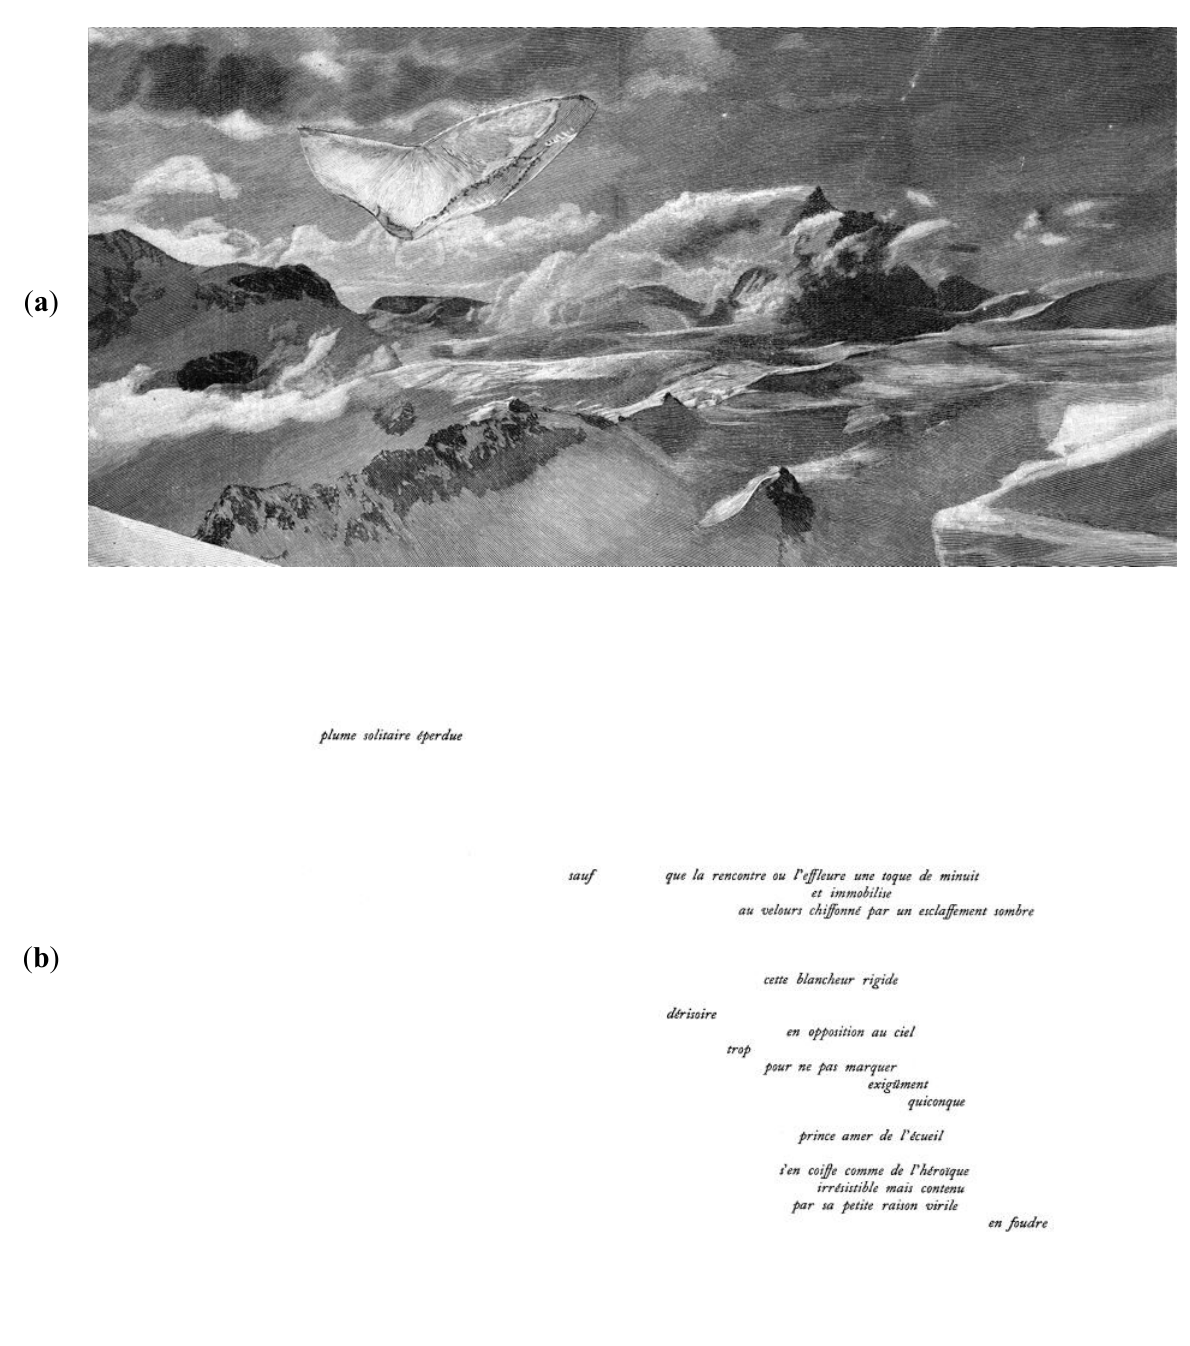
Figure 6. (a) Paper Collage comprised of original engravings from La Grande Illustré (1904); ( b ) Extract from Un Coup des Dés: a solitary plume overwhelmed/untouched that a cap of midnight grazes or encounters/and fixes/in crumpled velvet with a sombre burst of laughter/that rigid whiteness